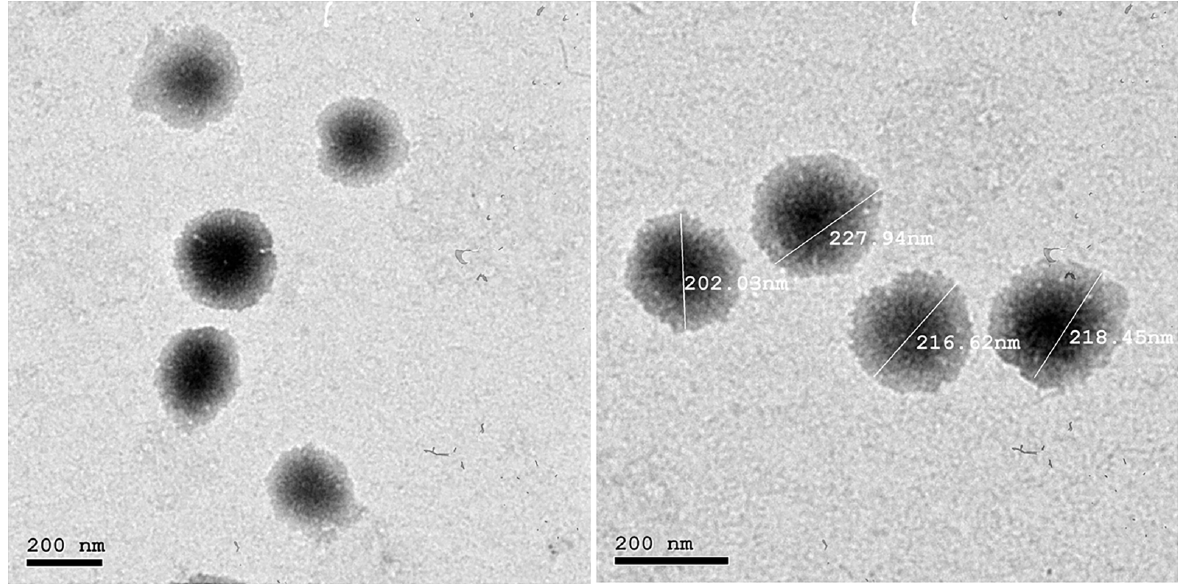
Figure 5. Transmission electron microscopy micrograph of the optimized DNa-BSVC formulation.